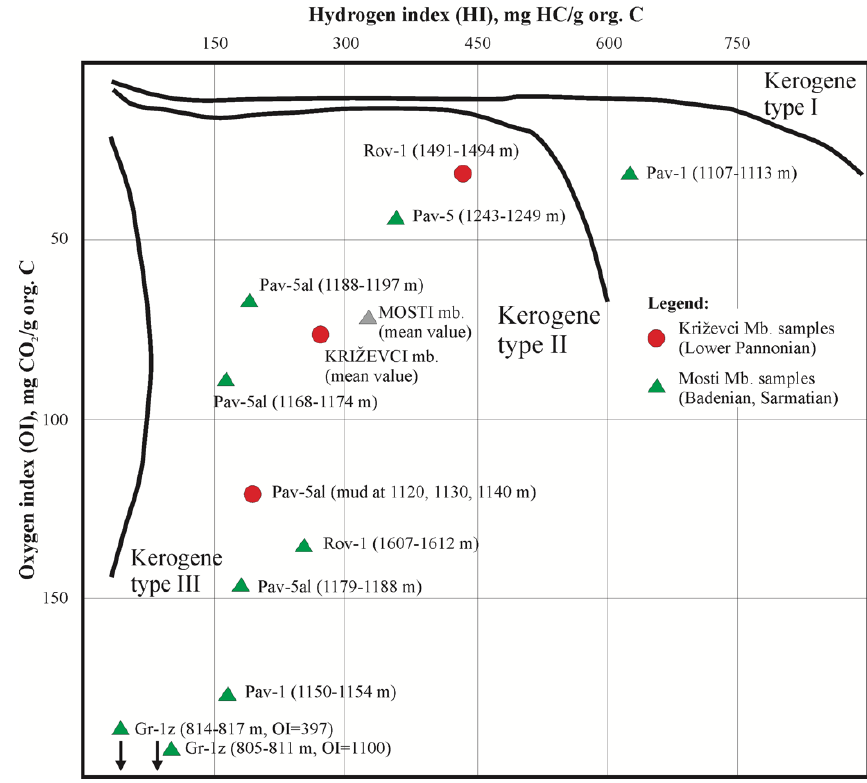
Figure 4. Van Krevelen diagram of kerogen samples. The Bjelovar Subdepression, Croatia [16].